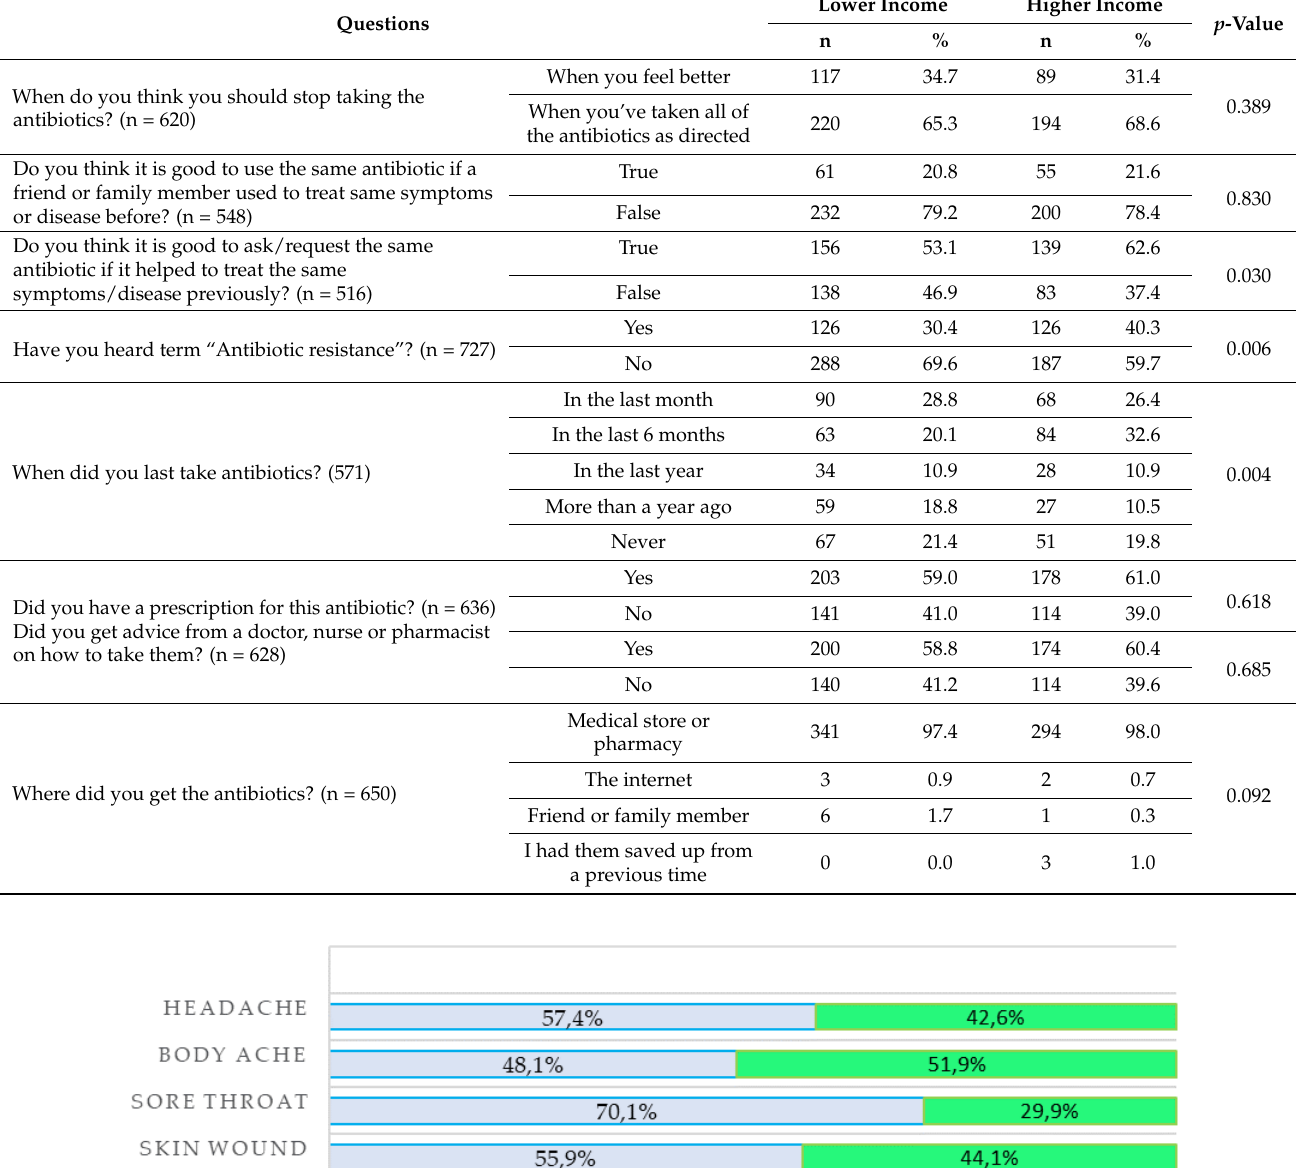
Table 6. Awareness about antibiotic use and resistance by the level of income.